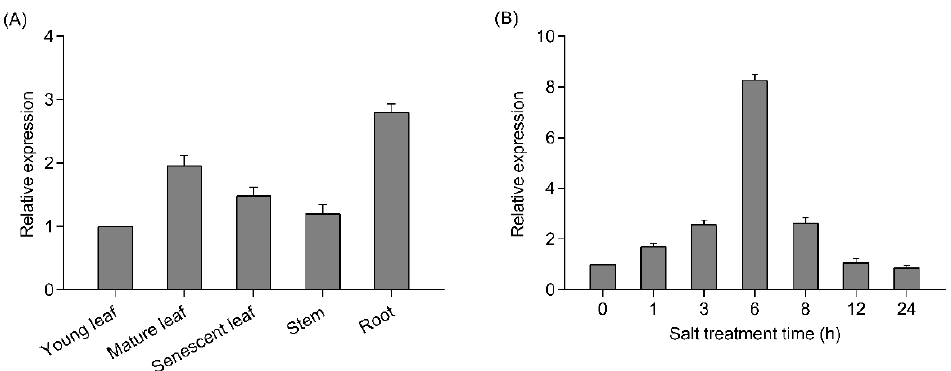
Figure 1. Expression patterns of PtrWRKY51 . ( A )Transcript level of PtrWRKY51 in various organs including young leaf, mature leaf, senescent leaf, stem and root of P. trichocarpa . ( B ) RT-qPCR analysis of PtrWRKY51 transcript levels under salt conditions. Data are shown as mean ± SE ( n = 6).